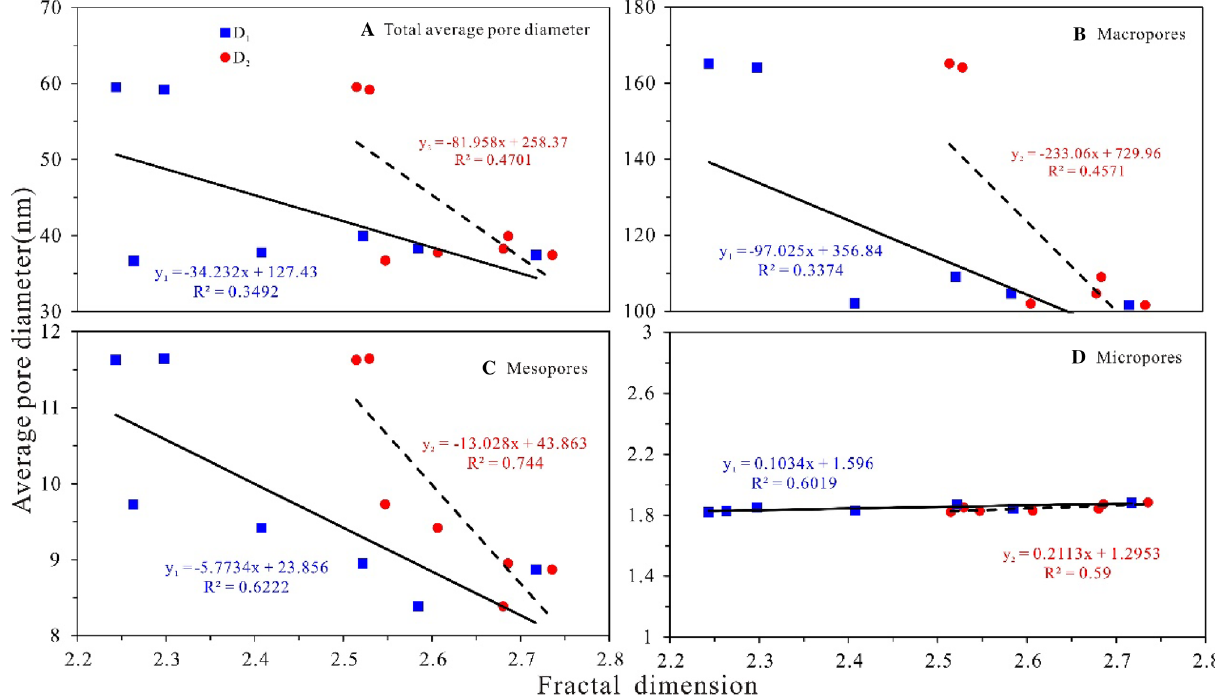
Fig. 7 Relationships between fractal dimensions and average pore diameters in pyrolyzed oil